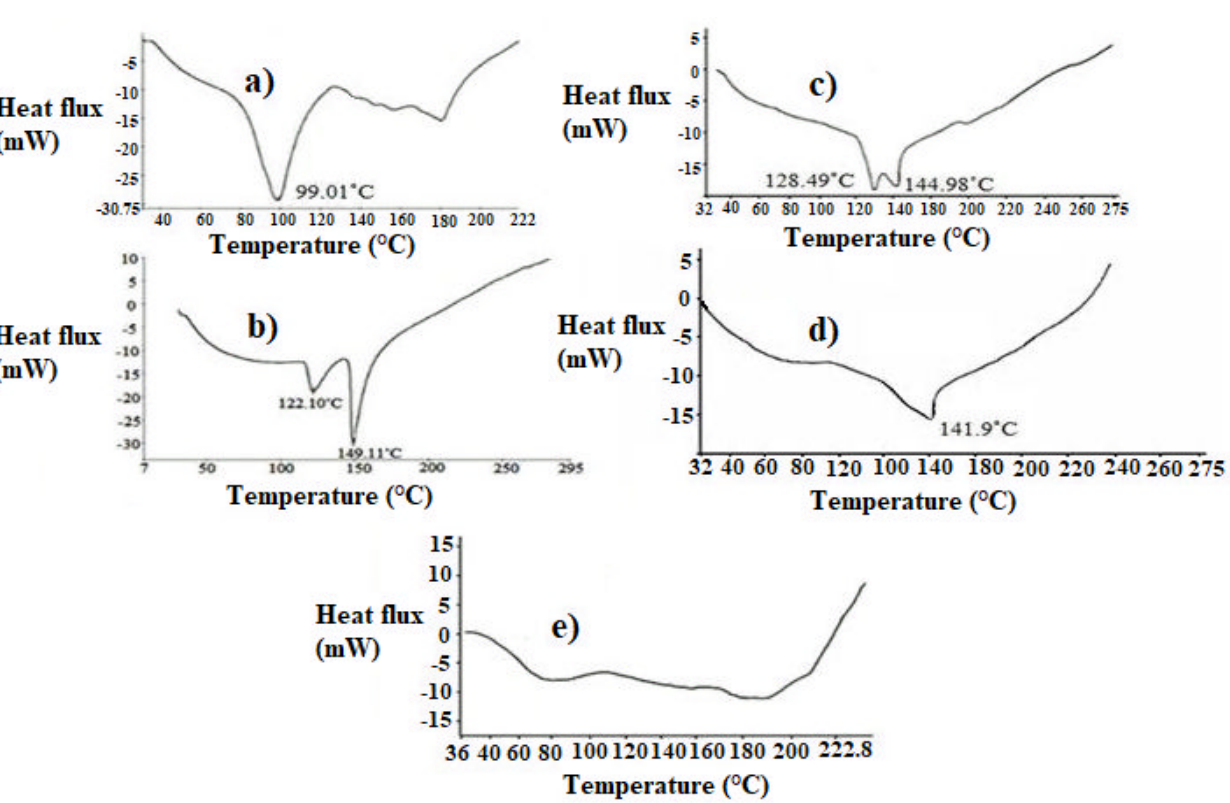
FIGURE 6 – DSC curves of Met HCl (a), Met base (b), PVP K30-Met base PM (1:1 w/w) (c), PVP K30-Met base PM (5:1 w/w) (d) and PVP K30-Met base SD (e).